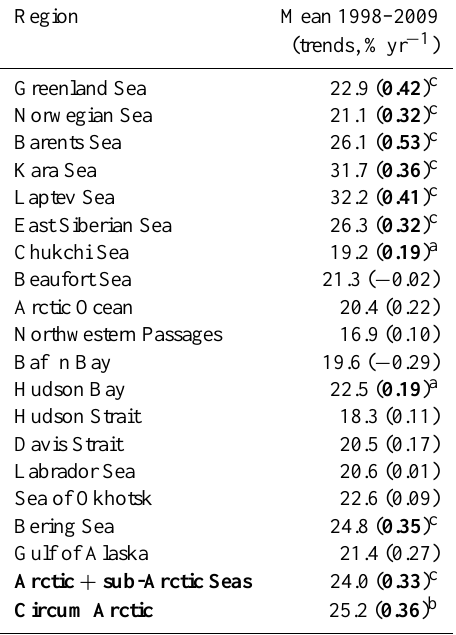
Table 5. Potential reduction of PP due to cloudiness (in %) as es- timated using 100 ∗ ( 1 − PP/PP clearsky ), where PP clearsky is the to- tal annual PP calculated assuming clear sky conditions (in paren- thesis, in %yr − 1 ). Significant trends are in bold text with super- script indicating the level of significance: (a) 0 . 05 < p < 0 . 1, (b) 0 . 01 < p < 0 . 05, and (c) p < 0 . 01